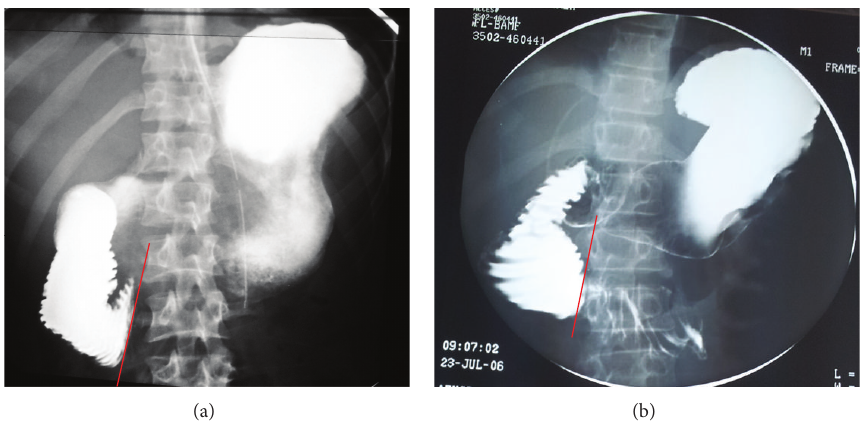
Figure 1: (a) and (b) Dilation of the duodenum with abrupt cut-off at its third part, coinciding with the line of the SMA (red line).